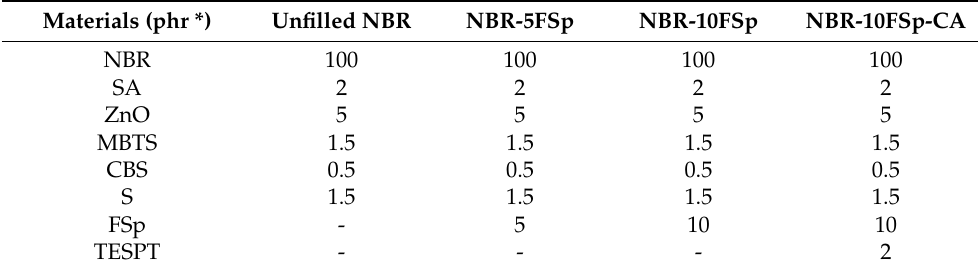
Table 1. Sample codes and compositions of NBR/FSp and NBR/FSp/CA composites. Materials (phr